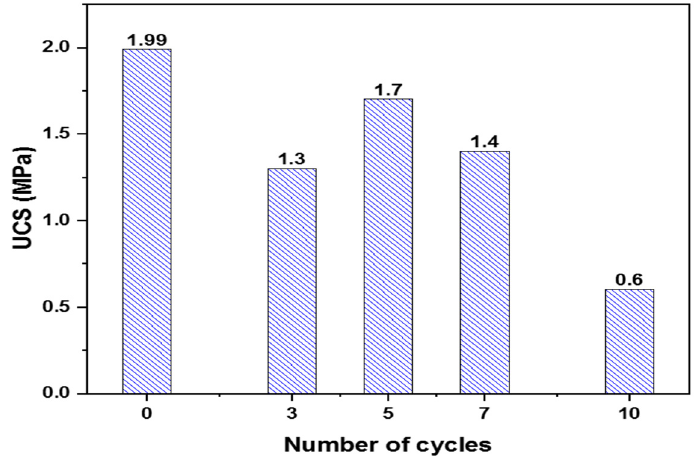
Figure 17. Variation in UCS with wet/dry cycles.